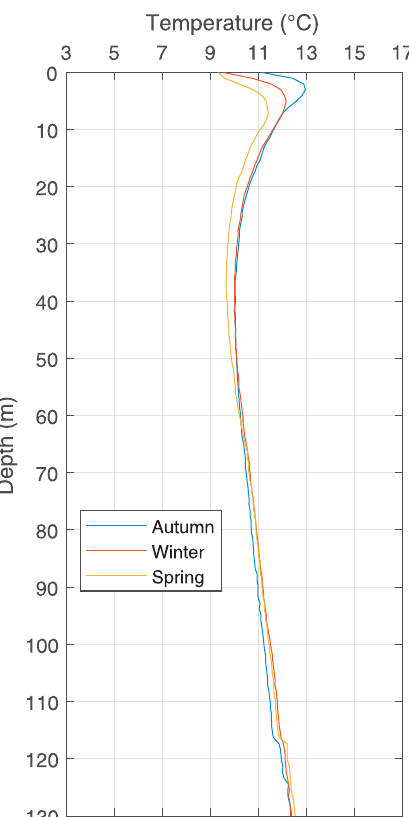
Figure 11. Average of measurements in boreholes in relation to